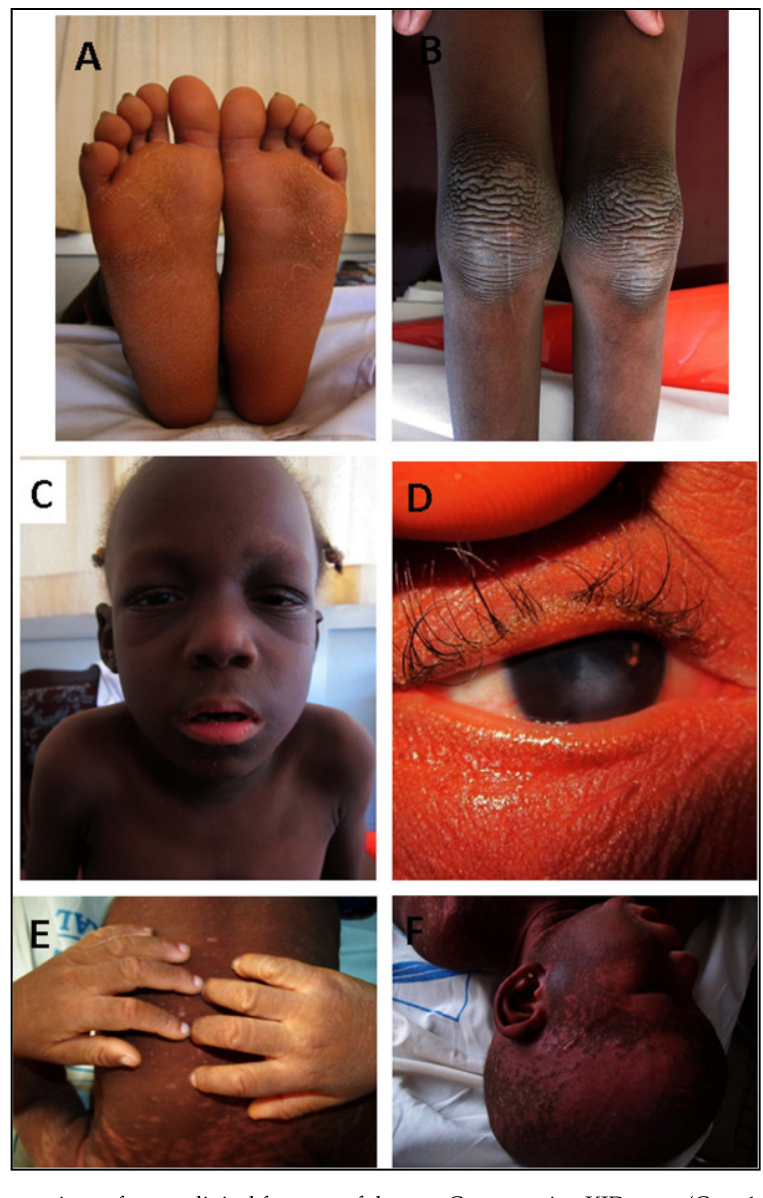
Figure 3 . Illustrations of some clinical features of the two Cameroonian KID cases (Case 1; panels A– D; Case 2 panels E and F). ( A ) Keratoderma of the soles; ( B ) Rippled hyperkeratotic plaques on the knees; ( C ) Hypotrichosis of the eyelashes and eyebrows; ( D ) Mild vascularizing keratitis; ( E ) Hyperkeratosis of the hands; ( F ) Alopecia, hypotrichosis, ichthyosiform erythrokeratoderma (extracted from the paper by Wonkam et al. [30]) .